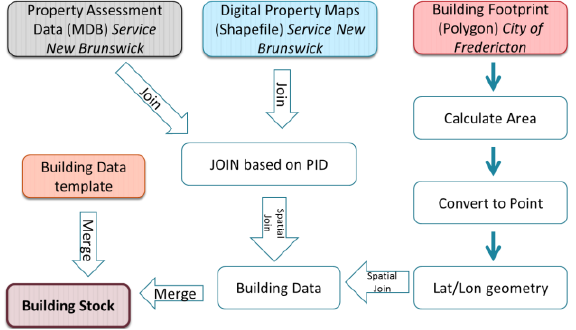
Figure 4 Process of assembling building data from source datasets into Hazus